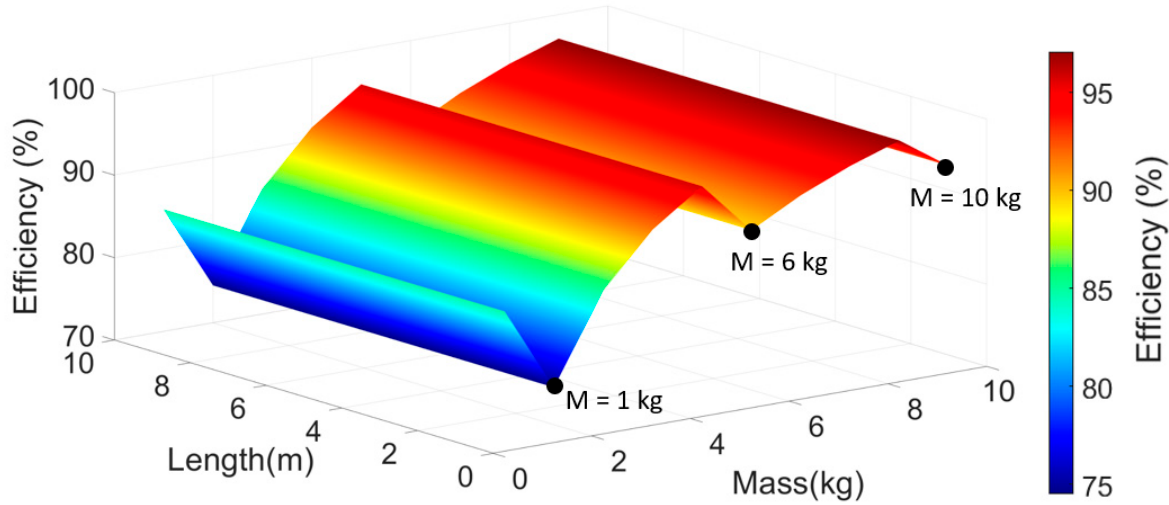
Figure 5. Generation efficiency according to the length and mass of the pendulum.